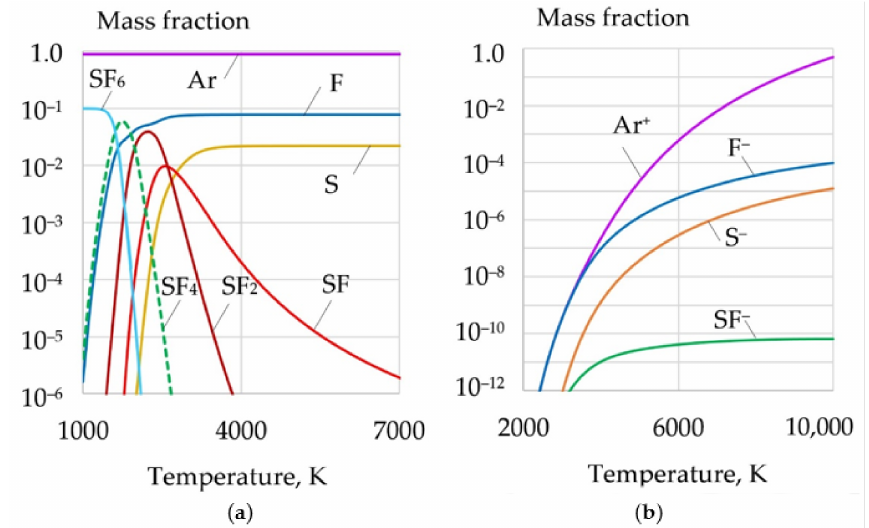
Figure 5. Mass fraction of components during dissociation ( a ) and ionization ( b ) of the mixture, wt.%: 90Ar + 10SF 6 . Endothermic reactions of dissociation and ionization of LaF 3 with a positive change in enthalpy lead to an increase in heat capacity, thermal conductivity, enthalpy of the plasma, and slight decrease in dynamic viscosity, as shown in Figure 6.